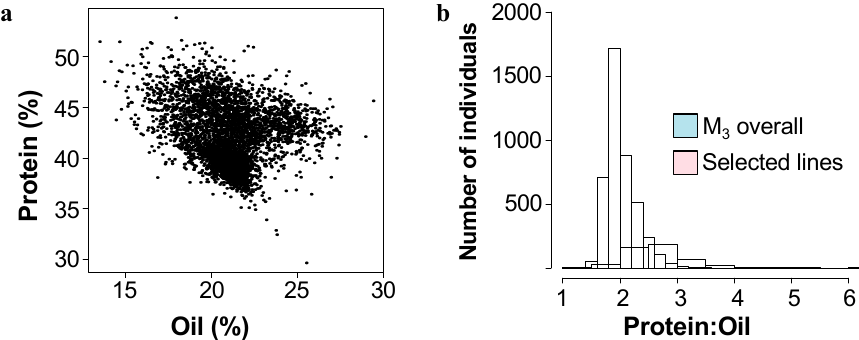
Figure 1. Mature seed protein and oil content in the mutant population. ( a ) Total protein and oil content in mature seeds as determined by NIR as % dry weight basis for 4300 M 3 lines of the mutant population. ( b ) Distribution of mature seed protein:oil ratio for all mutant lines (blue) and the selected mutant lines (pink) over five seasons.